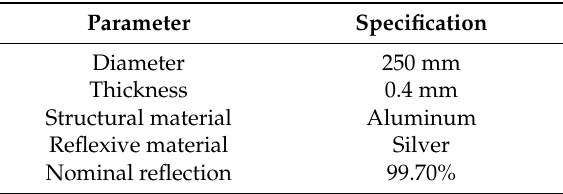
Table 1. Technical specifications provided by the manufacturer (reflective